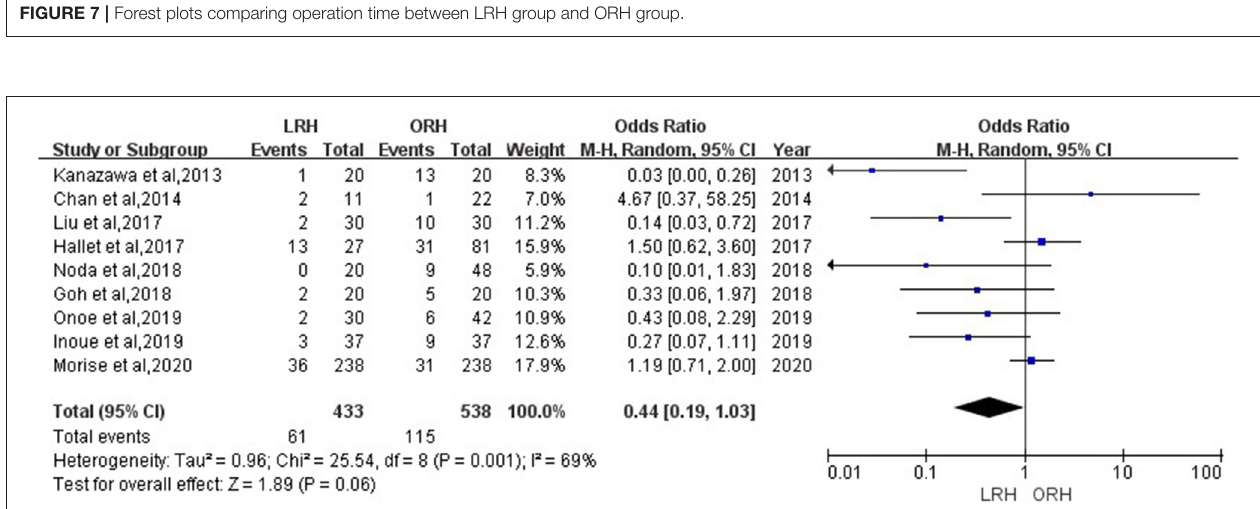
Frontiers in Oncology |